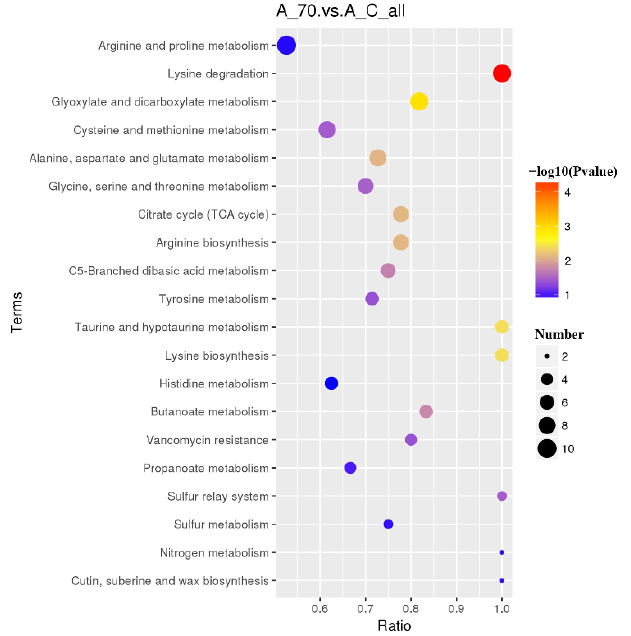
Figure 13. Bubble chart of KEGG enrichment results of differential metabolites between mutant 70 and the original strain. The size of the bubble indicates the number of genes enriched in the pathway.